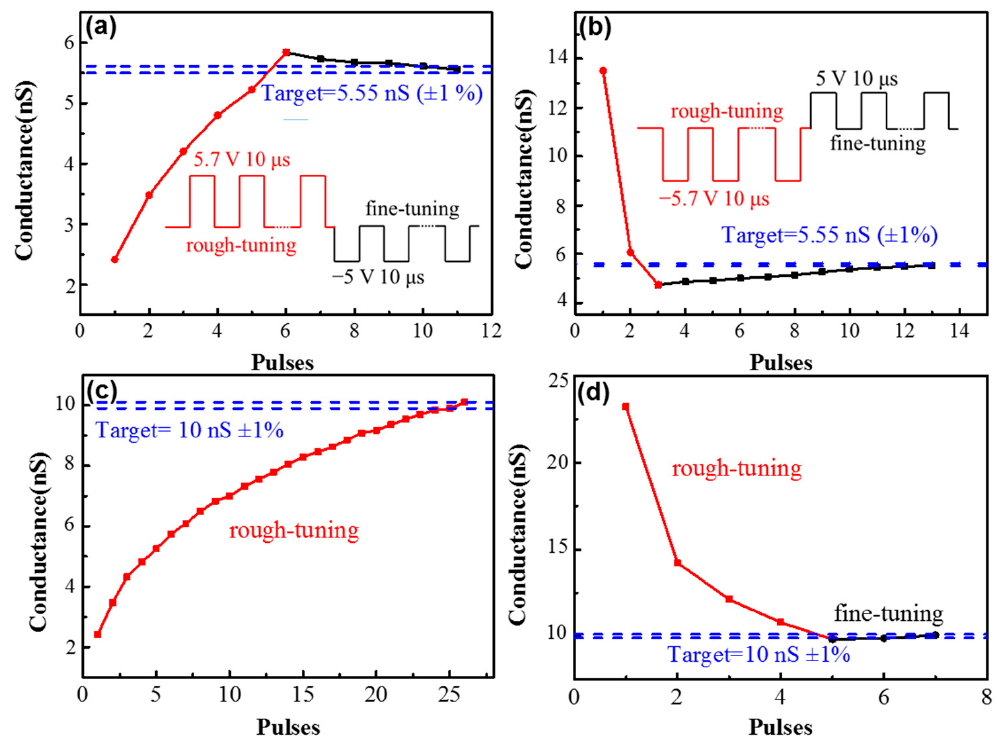
Figure 6. The bipolar conductance tuning to randomly determined target states (5.5 nS ± 1% and 10 nS ± 1%) under pulses with different initial states: ( a ) the initial state is 2.41 nS, and the target conductance